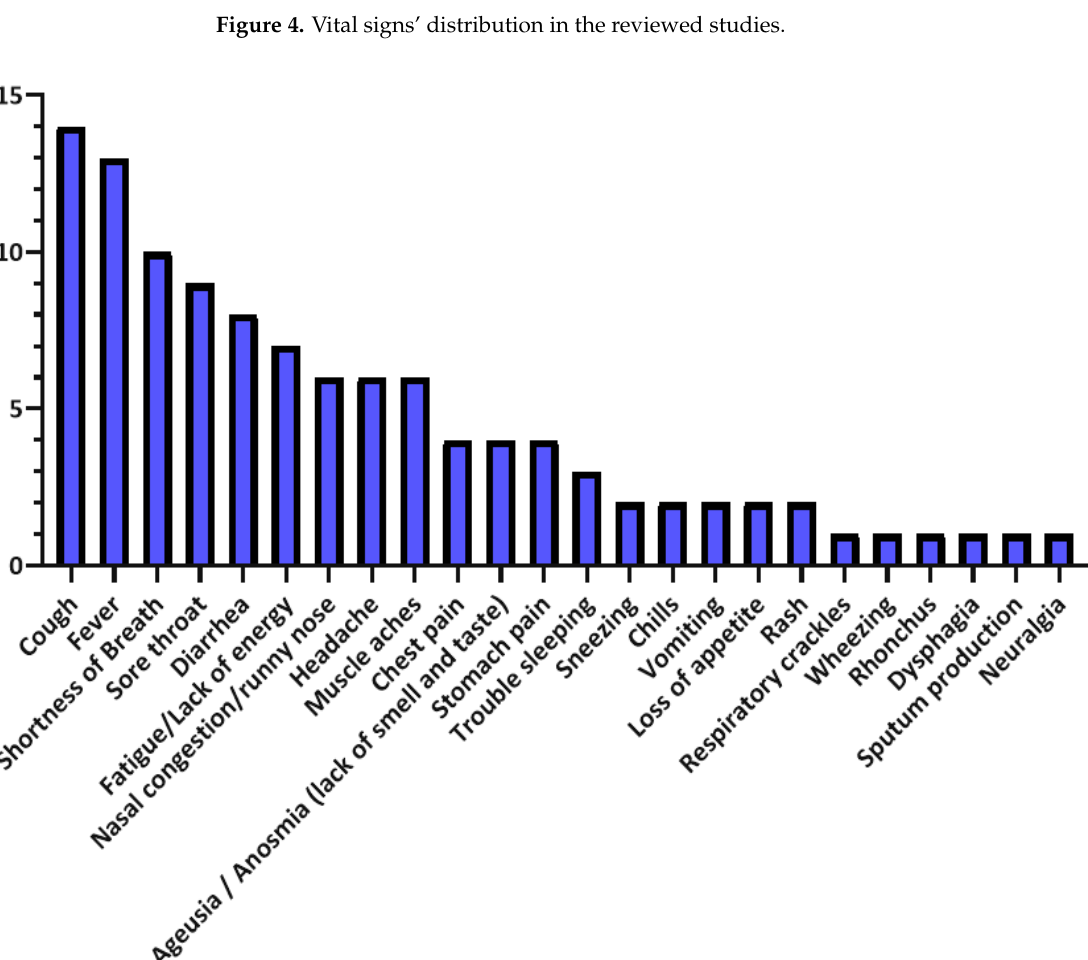
Figure 5. Symptoms’ distribution in the reviewed studies.